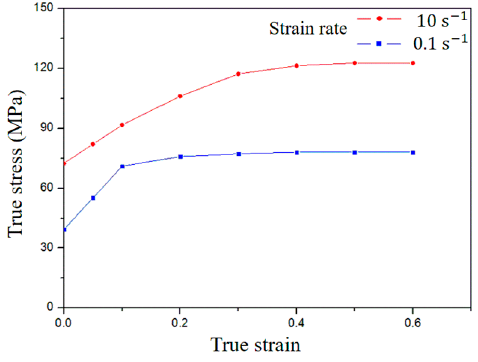
Figure 4. Flow curves of Al6061 at 260 °C for strain rate 0.1 s − 1 and 10 s − 1 .